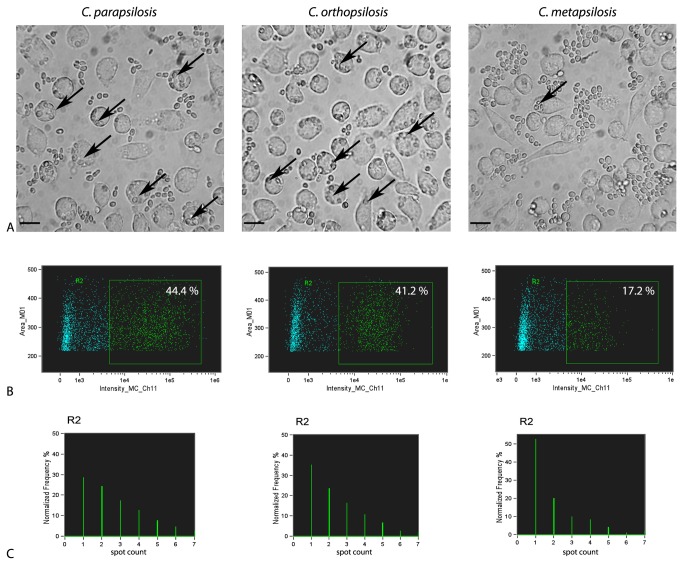
Phagocytosis of one representative isolate each of C. parapsilosis sensu stricto,

C

. orthopsilosis
 and

C

. metapsilosis
 by J774.2 macrophages.(A) Light microscopic picures of J774.2 macrophages phagocytosing C. parapsilosis sensu lato species, (B) phagocytosis of C. parapsilosis sensu stricto,

C

. orthopsilosis
 and

C

. metapsilosis
 by J774.2 macrophages assessed by quantitative imaging, R2: phagocytosing macrophage population discriminated by the presence of red fluorescence due to ingestion of Alexa Fluor 647-labeled yeast cells, (C) numbers of ingested yeast cell/macrophage in the R2 population in case of C. parapsilosis sensu stricto,

C

. orthopsilosis
 and

C

. metapsilosis
 determined by the spot-counting feature of IDEAS software.